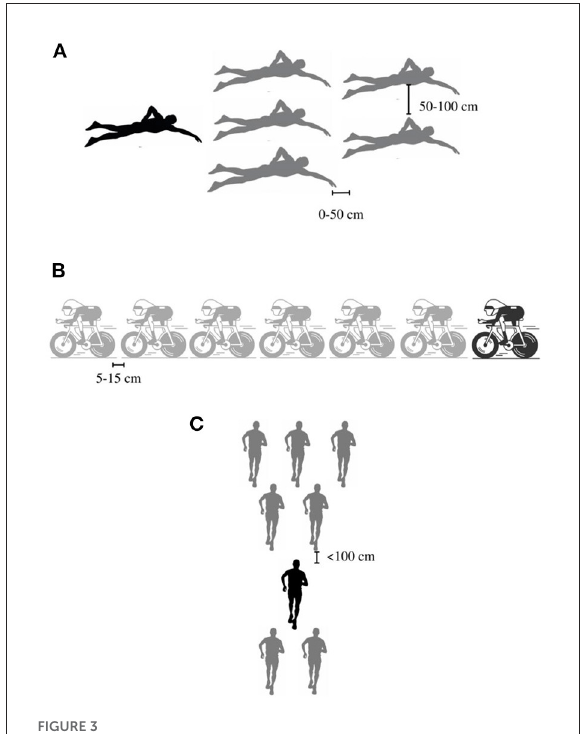
FIGURE3 Recommended drafting organizations for (A) Swimming, (B) Cycling and (C) Running. The blackest drawings represent the racing